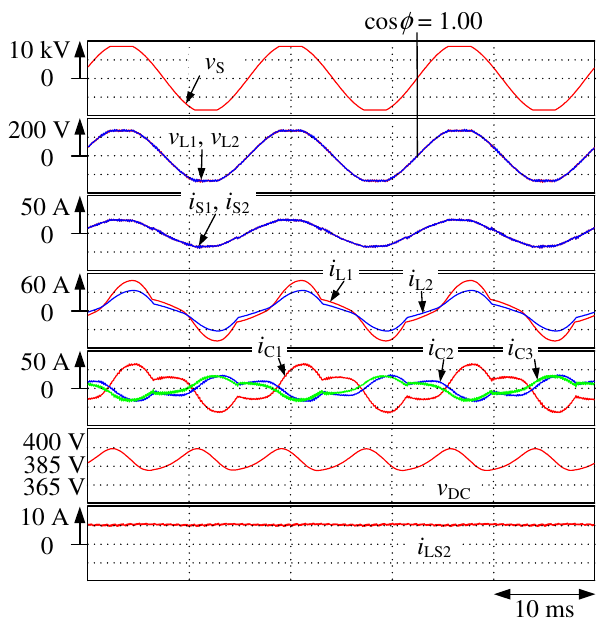
Figure 3. Simulation results for Figure 1 during battery-discharging